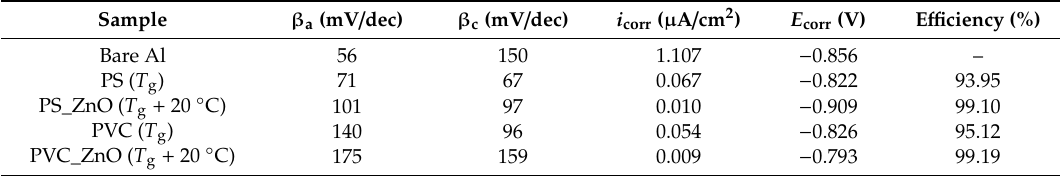
Figure 9. Tafel plots corresponding to the Al bare substrate and the Al samples coated with electrospun PS_ZnO and PVC_ZnO electrospun fibers which have been thermally treated and tested in 3.5 wt % NaCl aqueous solution. Table 1. Tafel analysis for uncoated Al substrate, PS_ZnO and PVC_ZnO samples thermally treated and tested in 3.5 wt % NaCl aqueous solutions.